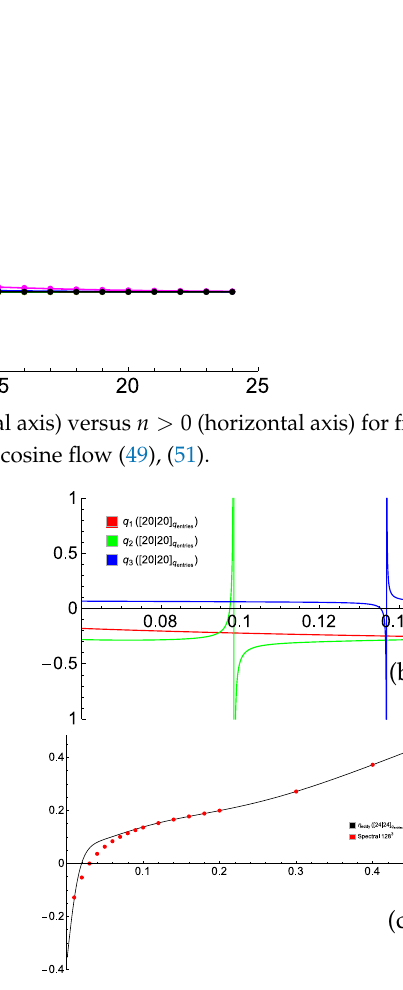
Figure 5. Minimum eddy diffusivity (53) (vertical axis) for the sample flow (49), (51) computed using Padé approximants of the quantities q i (52) of orders [20/20] ( a ), [18/18] (green line) and regularized [20/20] (black line) ( c ), and [24/24] ( d ). Behavior of the [20/20] Padé approximants of q i (vertical axis) near the points, where Froissart doublets are located ( b ). Horizontal axis: magnetic molecular diffusivity η . Red dots: minimum eddy diffusivity computed by spectral methods (resolution of 128 3 Fourier harmonics) individually for the respective η